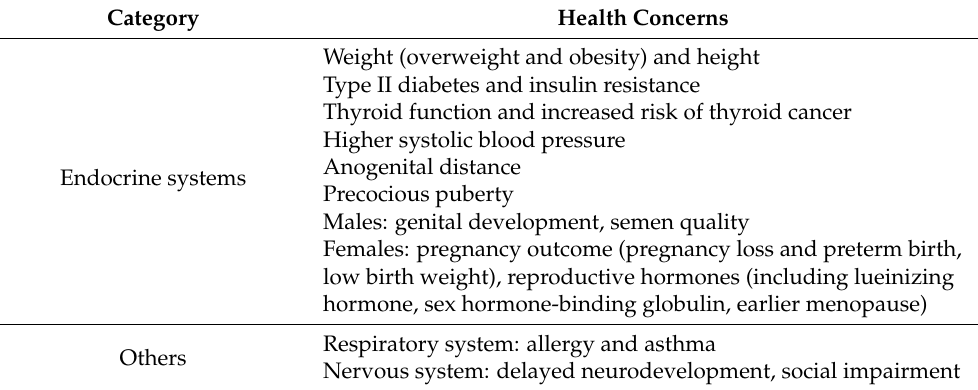
Table 2. Health impacts on children.